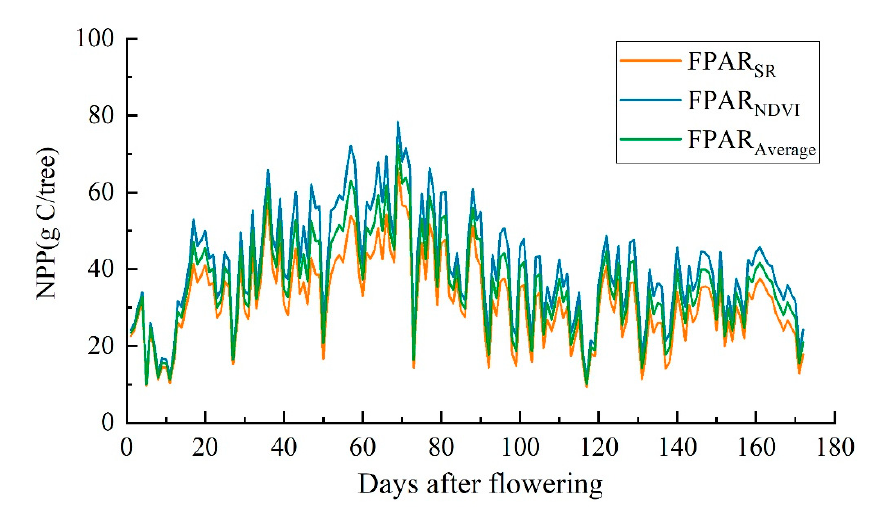
Figure 6. Mean apple tree NPP for the entire growing season.